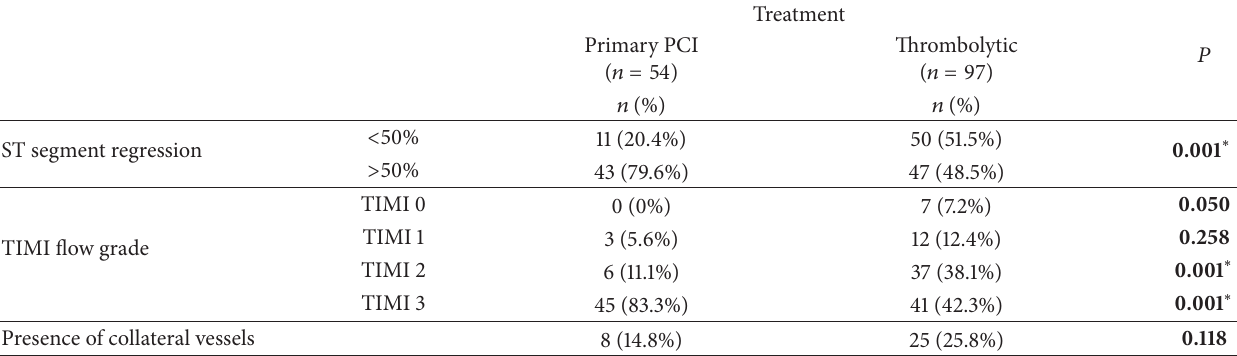
Table 4: Comparison of electrocardiographic ST segment regression, TIMI flow grades, and the presence of collateral circulation between two treatment